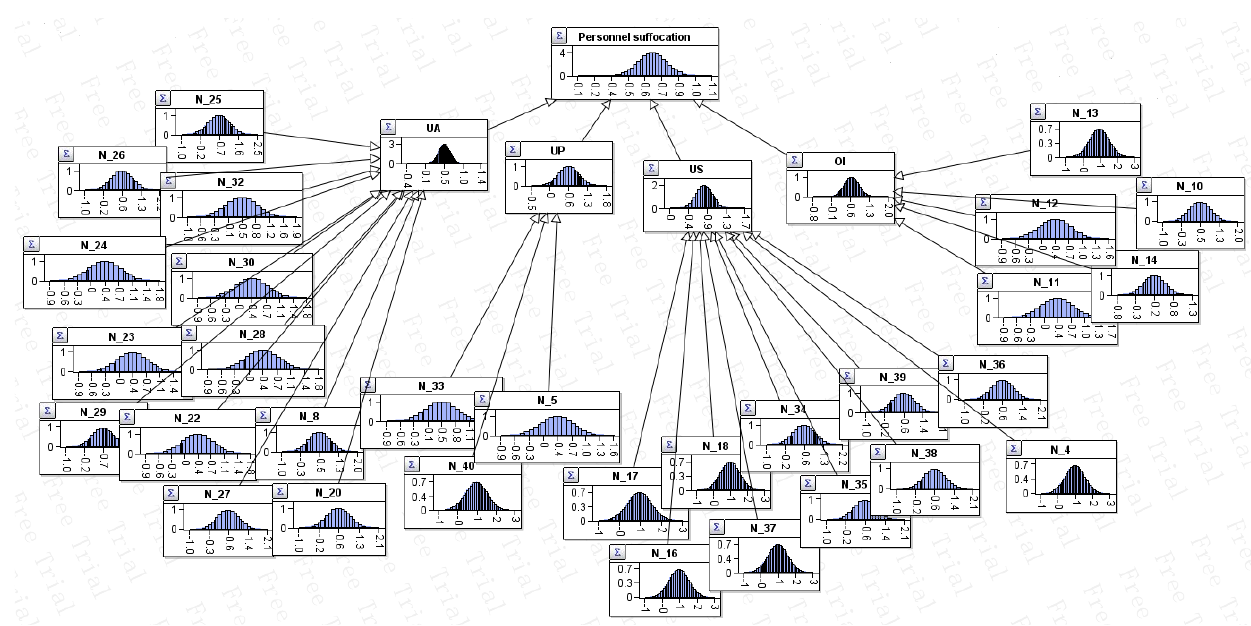
Figure 6. The results of running the BN model.